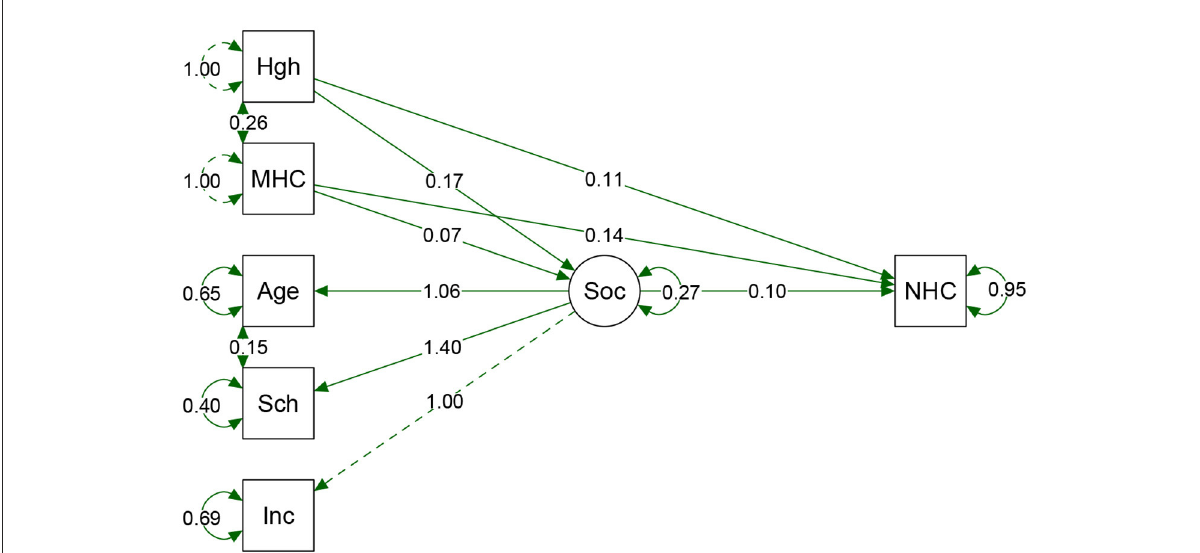
FIGURE3 Result from path analyses of the total sample. Hgh, height; MHC, Maternal HC; Sch, Schooling. Inc, Income; Soc, Socio (latent variable); NHC, Neonatal HC. Arrow direction indicates direct and indirect effects of variables that predict NHC. The direction of Socio arrows for the three predecessor variables shows the contribution of each indicator value. As far as we could verify; schooling had a greater weight on Socio variable. Circles show the standard error of a parameter. Model fits: p -value = < 0.0001. Chi-square (X 2 ) = 0.340, Degree of Freedom (df) = 5. X 2 /df = 0.068. CFI = 0.999, TLI = 0.997. RMSEA = 0.013 (95%CI 0.000–0.052). Adjustment parameters suggested that the model is acceptable, indicating that the composition of these variables could explain the effects on the proportion of NHC.